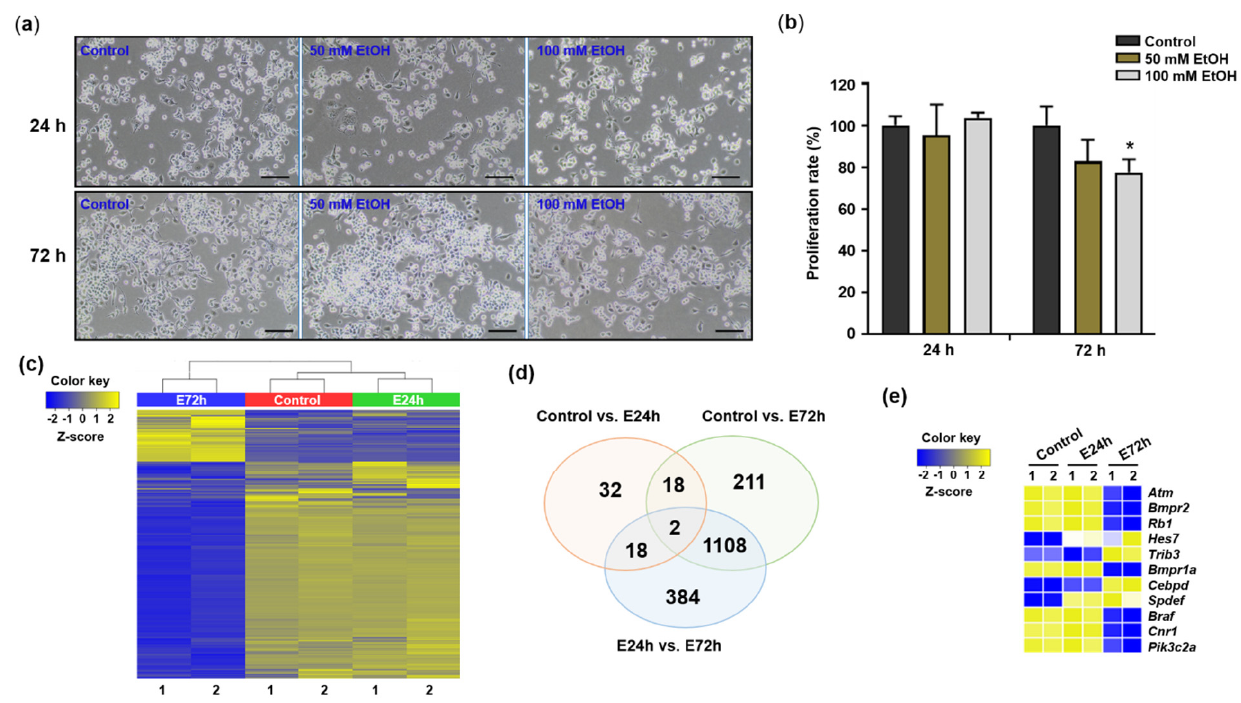
Figure 1. Changes of cell proliferation and gene expression in Neuro2a cells in response to ethanol. ( a ) Morphology of Neuro2a cells exposed to ethanol at 100 × magnification. The cells were exposed to ethanol (50 and 100 mM) for 24 (upper panels) and 72 h (lower panels). Scale bar = 100 µm. ( b ) Proliferation of Neuro2a cells exposed to ethanol (EtOH). Proliferation rates of the cells exposed to ethanol (50 and 100 mM) for 24 and 72 h were evaluated. Ethanol treatments were performed as three independent replicates to guarantee reliable results. To compare the differences among control and ethanol-treated cells, one-way ANOVA and Tukey’s post-hoc tests were used. *Significantly different from control (* p < 0.05). ( c ) Heatmap generated from hierarchical clustering analysis of differentially expressed transcripts among control and ethanol-treated (E24h and E72h) groups. ( d ) Venn diagram showing the overlap of transcripts among control, E24h, and E72h groups. ( e ) mRNAs selected from the total transcripts for RT-qPCR. Cells exposed to 100 mM ethanol for 24 h, E24h; cells exposed to 100 mM ethanol for 72 h, E72h.